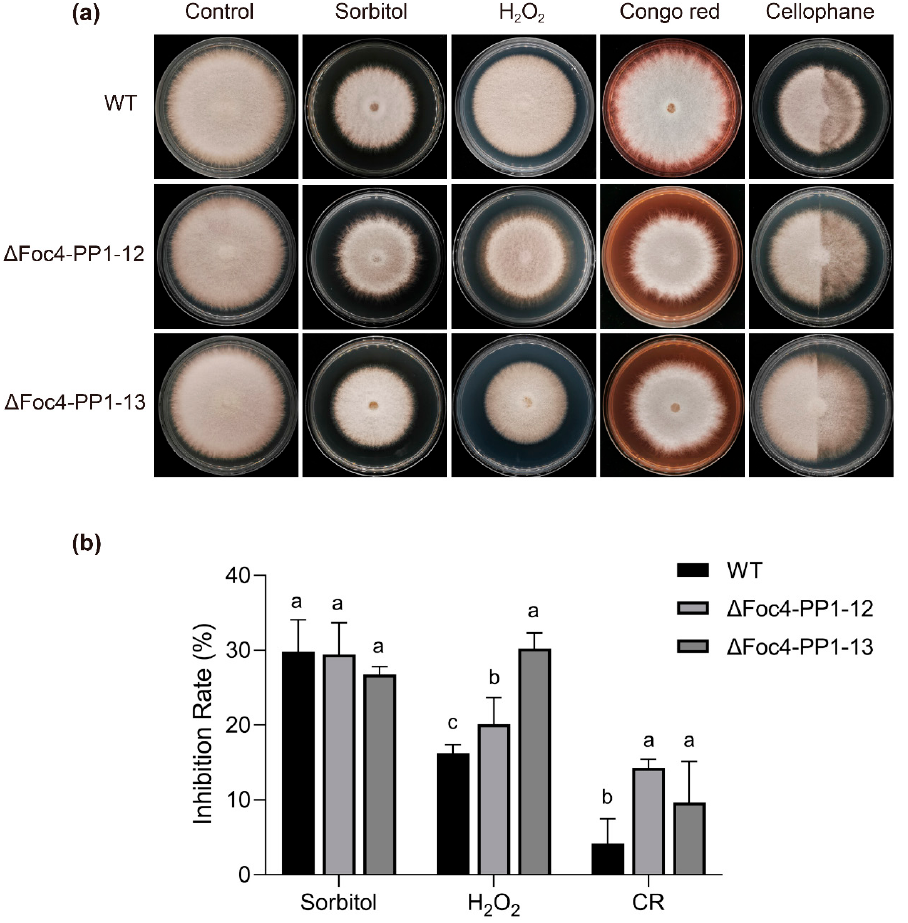
Figure 3. Sensitivity test of the WT and Δ Foc4-PP1 strains against abiotic stress. ( a ) Colony appearance of the WT, ∆ Foc4-PP1-12, and ∆ Foc4-PP1-13 strains on PDA plates supplemented with 1 M sorbitol, 25 mM H 2 O 2 , 200 µg/mL Congo red, and cellophane, respectively. Plates were incubated at 28 °C for six days after inoculation. ( b ) Quanti fi cation of colony size inhibition as appeared in ( a ). The strains cultured under non-stress conditions were used as controls. The inhibition ratio was calculated as the percentage growth reduction of the treated samples compared to the control. The values were analyzed with Duncan’s multiple range tests by SPSS. Columns with di ff erent le tt ers indicate a signi fi cant di ff erence ( p < 0.05). To investigate the in fl uence of Foc4-PP1 on plant immunity, Foc4-PP1 and its signal peptide-de fi cient mutant (Foc4-PP1 ∆ sp ) were transiently expressed in N. benthamiana (Figure 4a). The expression of GFP and of a mammalian proapoptotic factor BAX were used as negative and positive controls. Twelve hours after the fi rst inoculation, BAX-expressing Agrobacterium was applied at the same sites. The Bax protein is a mem- ber of the B-cell lymphoma-2 (BCL-2) family, which control the intrinsic apoptosis pathway [35]. The BAX-triggered cell death symptoms in N. benthamiana resembled the hypersensitive response by the plant immune system [36]. We found that Foc4-PP1 and Foc4-PP1 ∆ sp did not induce cell death. Moreover, cell death triggered by BAX in the leaves co-expressing BAX and Foc4-PP1 ∆ sp was almost completely suppressed (Figure 4b). These